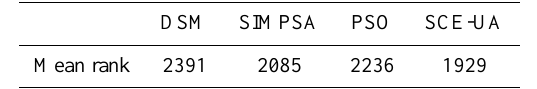
Table 4. Mean ranks of the different optimizaton method’s perfor- mances.